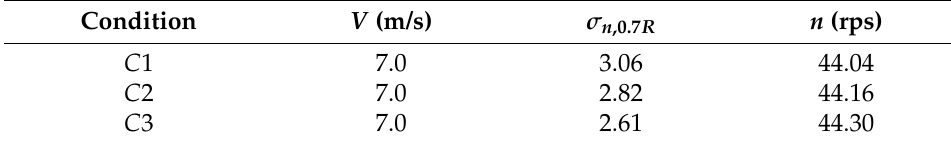
Table 2. Model test